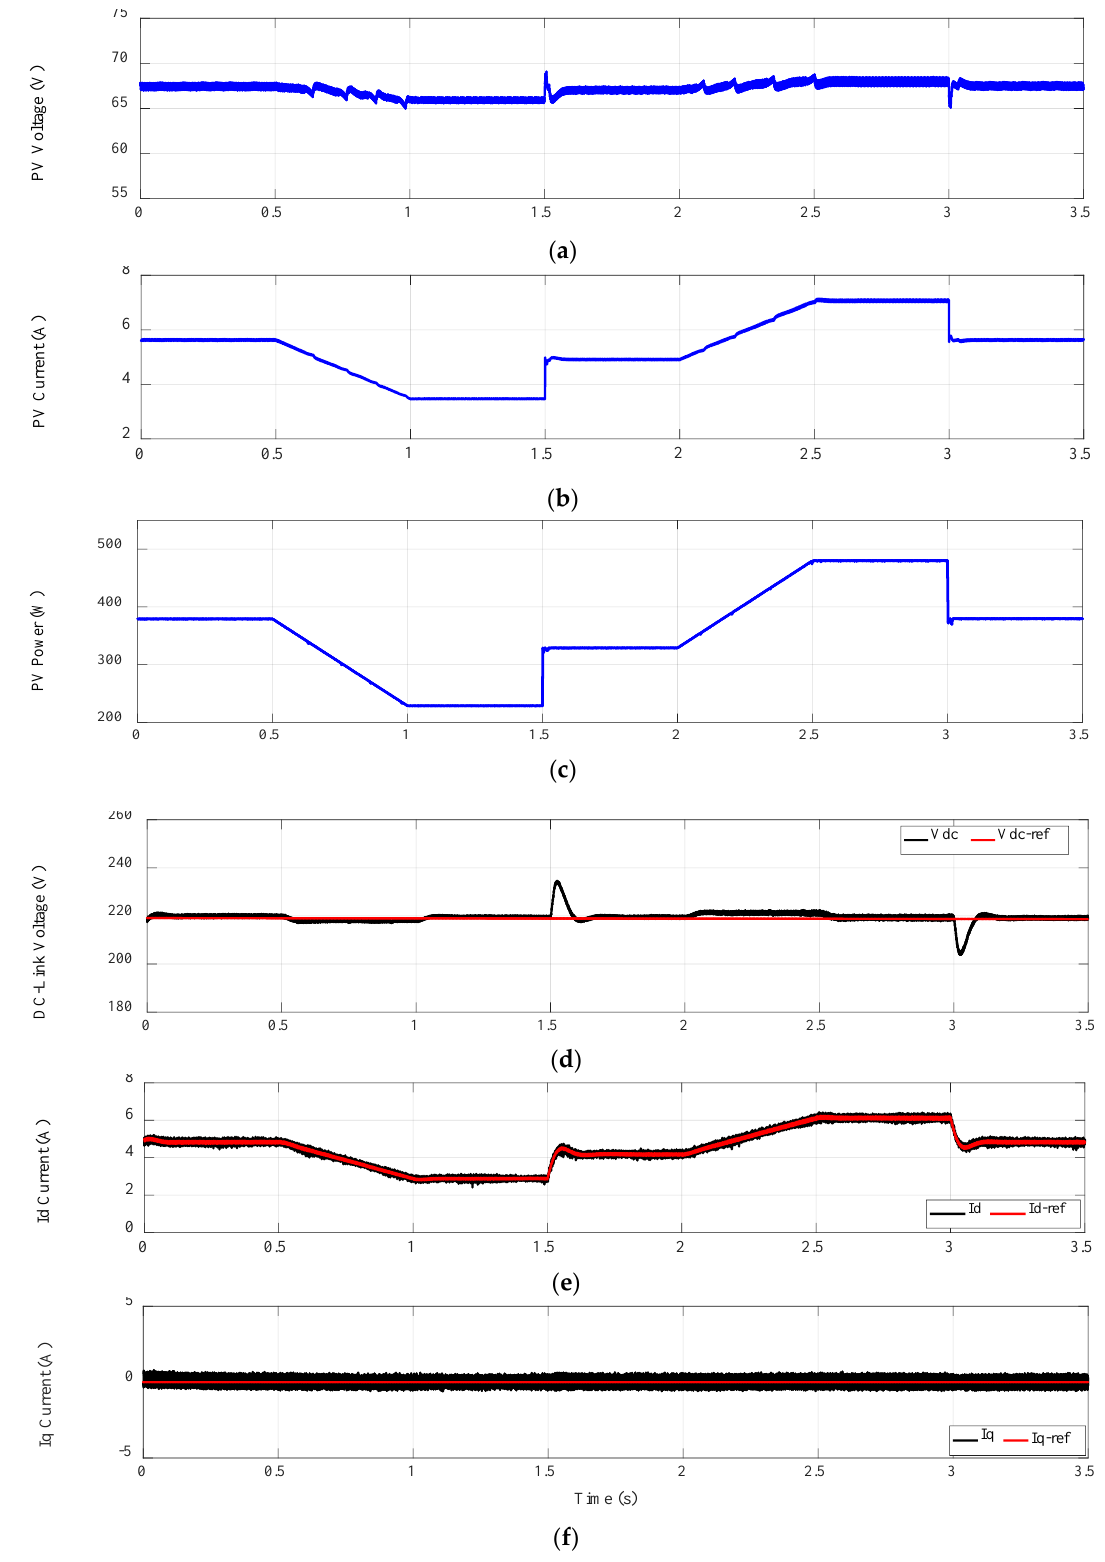
Figure 11. Simulation results of grid-tied PV system with the conventional control scheme; under irradiation changes. ( a ) PV Voltage; ( b ) PV Current; ( c ) PV Power; ( d ) DC−Link Voltage; ( e ) Id Current and ( f ) Iq Current.